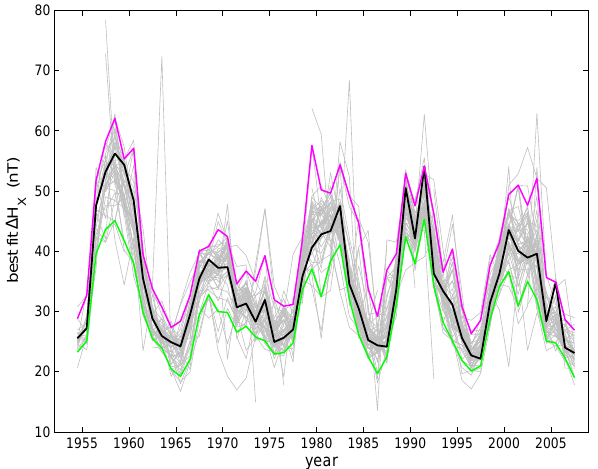
Fig. 3. Annual, mean diurnal range variations from 62 mid- and low-latitude stations (in grey), 1H X (where X is the observatory code), linearly regressed against the variation for Nurmijarvi (in black), 1H NUR . The green and mauve lines are the 5th and 95th percentiles of the distribution for each year. The 62 stations selected from the total of 81 analysed are those that gave a correlation with 1H NUR exceeding 0.65 and were at a corrected magnetic latitude 3 below 60 ◦ .